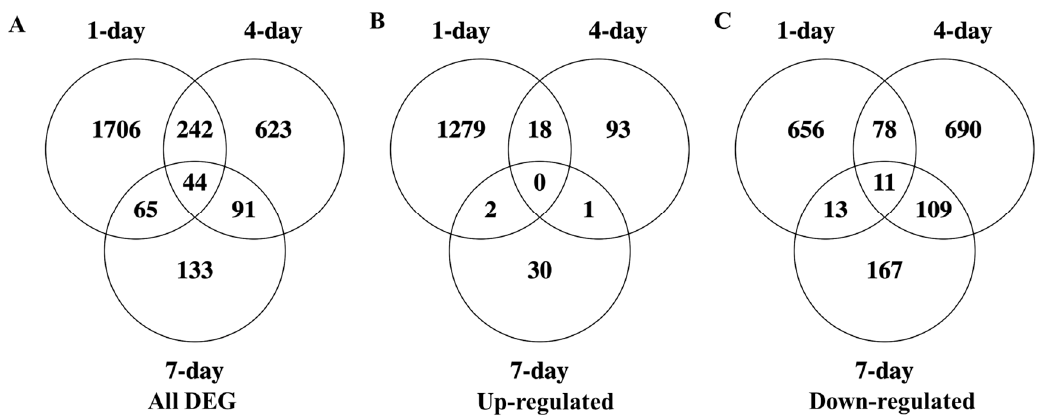
Figure 5. Comparison of DEG through early nematode infection in the resistant pepper cultivar. ( A ) Total number of DEG between infected and uninfected resistant cultivar at each time point. ( B ) Upregulated DEG identified between infected and uninfected resistant cultivar, ( C ) downregulated DEG identified between infected and uninfected resistant cultivar samples.